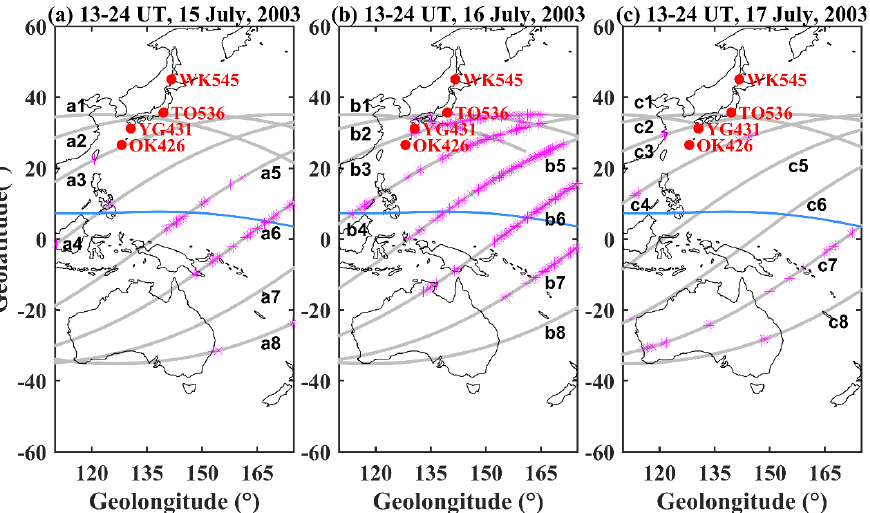
Figure 7. ROCSAT-1 ascending tracks marked with different labels over the Eastern Asian sector during 13–24 UT on ( a ) 15, ( b ) 16, and ( c ) 17 July 2003. The purple stars along the ROCSAT-1 orbits represent each of the identified density irregularity structures (the criterion of σ ≥ 0.3%) obtained from the method proposed by Su et al. [1]. The red dots represent the geographic location of the four ionosondes (WK545, TO536, YG431, and OK426 used in this study). The blue lines indicate the geomagnetic equator.